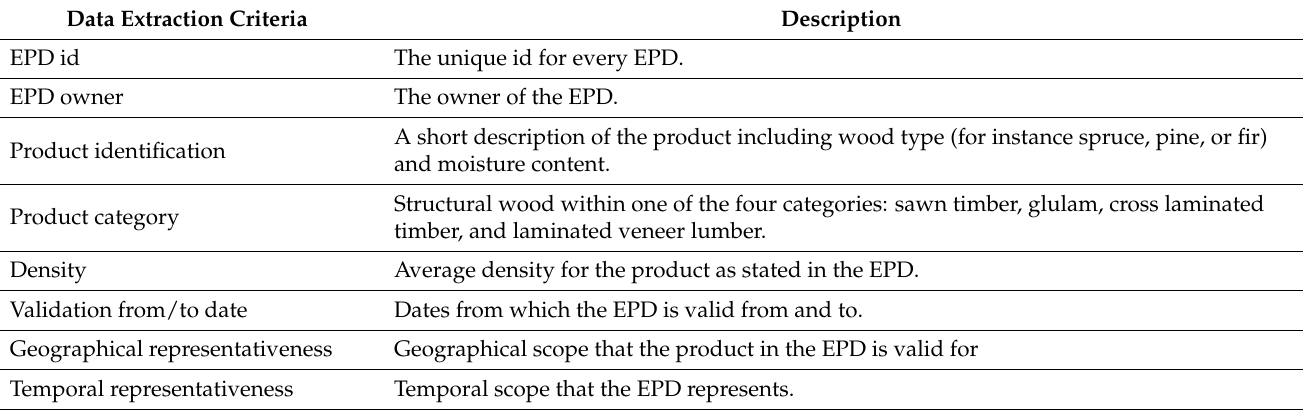
Table 1. Data extraction criteria used for the EPD